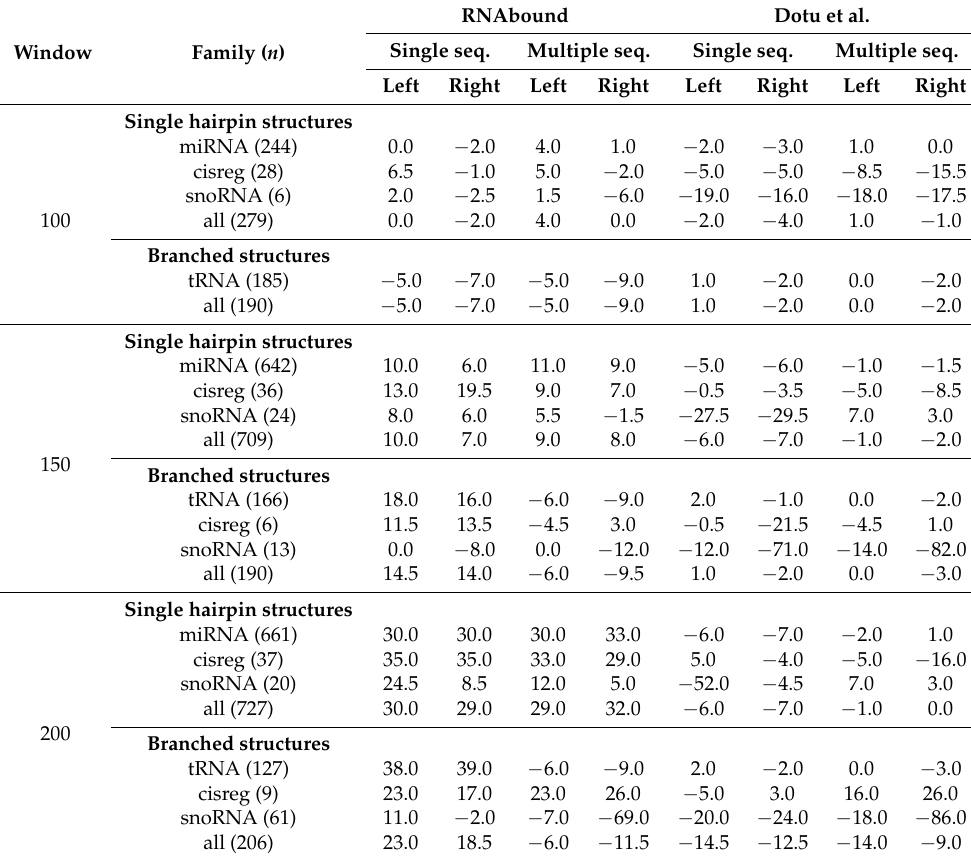
Table 2. The table shows the median value of the differences between the predicted and actual boundaries of structured RNAs using RNAbound and Dotu et al. approaches. The base pair probabilities for single sequences and multiple sequence alignments were computed using RNAfold and PETfold , respectively. Only Rfam families with more than five entries are listed